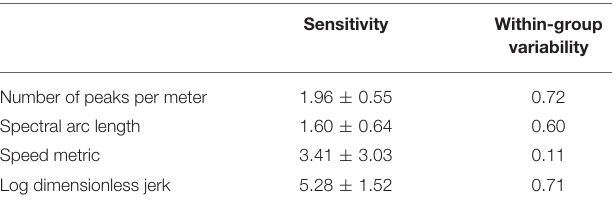
TABLE 2 | The means and standard deviations for the sensitivity measure and the within-group variability index for the four smoothness parameters.